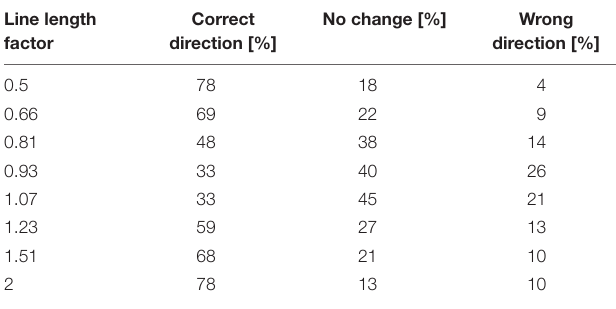
TABLE 3 | Type of level adjustment in response to the stimulus manipulations given in the first